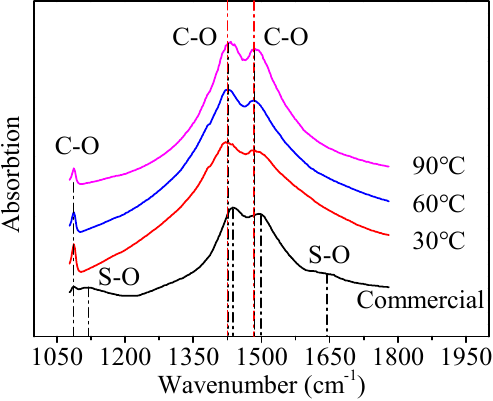
( b ) Figure 3. ( a ) XRD patterns of of Li 2 CO 3 samples before and after recrystallization in Na 2 CO 3 solution; ( b ) Variation of SO 42 − in Li 2 CO 3 sample after recrystallization with reaction time. 3.3.1. Behavior of Adsorbed SO 42 − Figure 4 shows the FT-IR spectra of Li 2 CO 3 before and after recrystallization in 1.0 mol·L − 1 Na 2 CO 3 solution at 30–90°C for 3.0 h . The peaks located at 1090 cm − 1 , 1430 cm − 1 and 1482 cm − 1 were attributed to the vibration of the symmetric (1090 cm − 1 ) and antisymmetric (1430 cm − 1 and 1482 cm − 1 ) stretching vibrations of C-O bond in Li 2 CO 3 , respectively, while the peaks located at 1118 cm − 1 and 1650 cm − 1 were attributed to the symmetric (1118 cm − 1 ) and antisymmetric (1650 cm − 1 ) stretching vibrations of S-O bond of Li 2 SO 4 , respectively. The increase of temperature from 30 °C to 90 °C led to the enlargement of the peaks for Li 2 CO 3 and the shrinkage of the peaks for SO 42 − , indicating the enhanced desorption of SO 42 − from Li 2 CO 3 surface at elevated temperature. Comparing the data in Figure 1b with those in Figure 4, it was known that the peaks for the stretching vibration of C-O